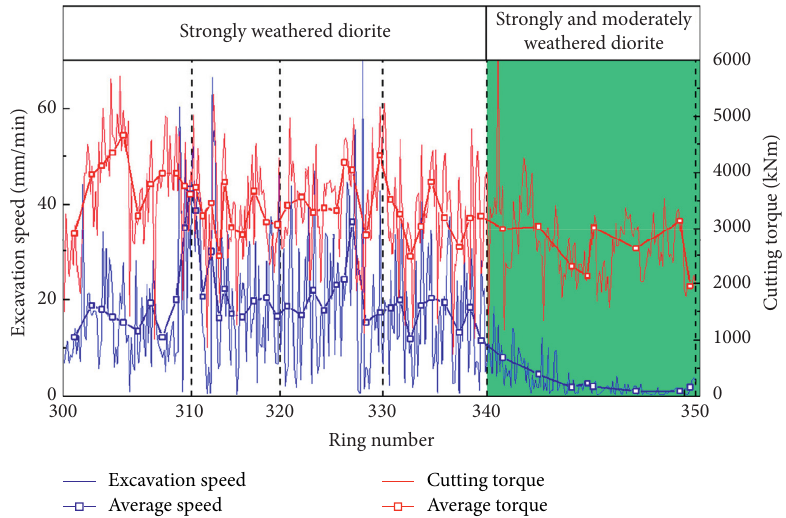
Figure 4: Monitoring results of excavation speed and cutting wheel torque at 300–350